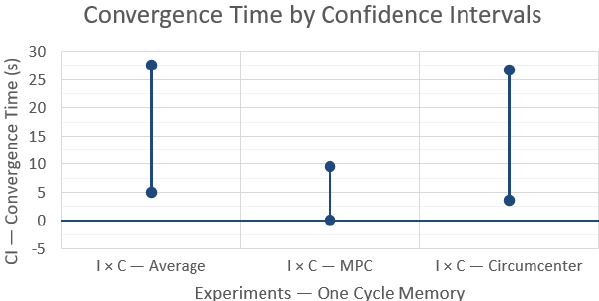
Figure 5. Differences in convergence time for each rendezvous technique with and without message losses, with one communication cycle memory, and with 99% confidence intervals.